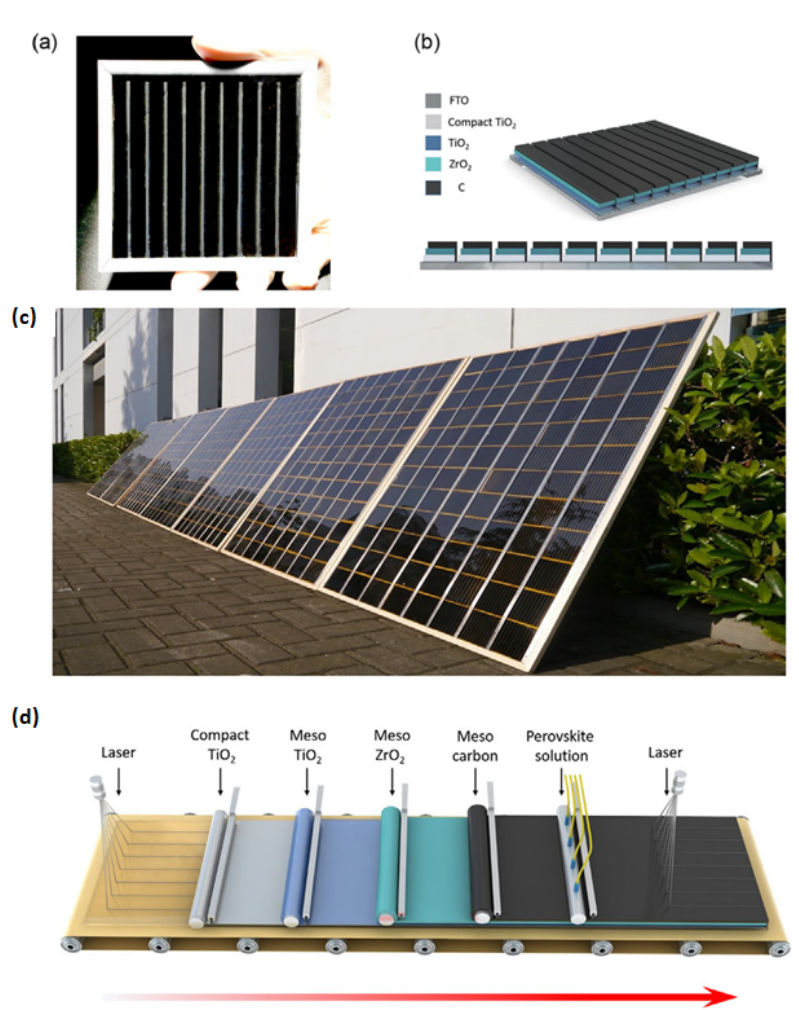
Figure 18. ( a ) Image of a monolithic printable PSM with 10 subcells. ( b ) The monolithic interconnec- tion scheme of the module. ( c ) Image of 7 m 2 printable perovskite solar panels. ( d ) Schematic illus- tration of the proposed production line of PSM [96]. (Reproduced from Ref. [96], 10.1002/solr.201600019, with permission.)